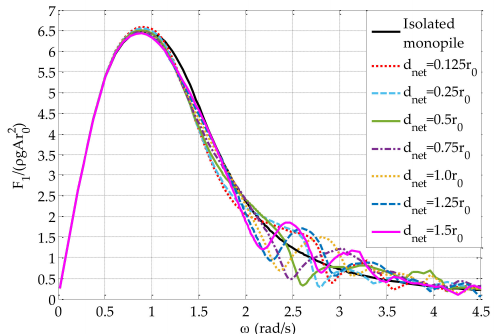
Figure 10. Comparisonof the non-dimensional surge exciting forces applied on the monopile with and without (isolated monopile) the oblate spheroidal WECs for β = 0 o .